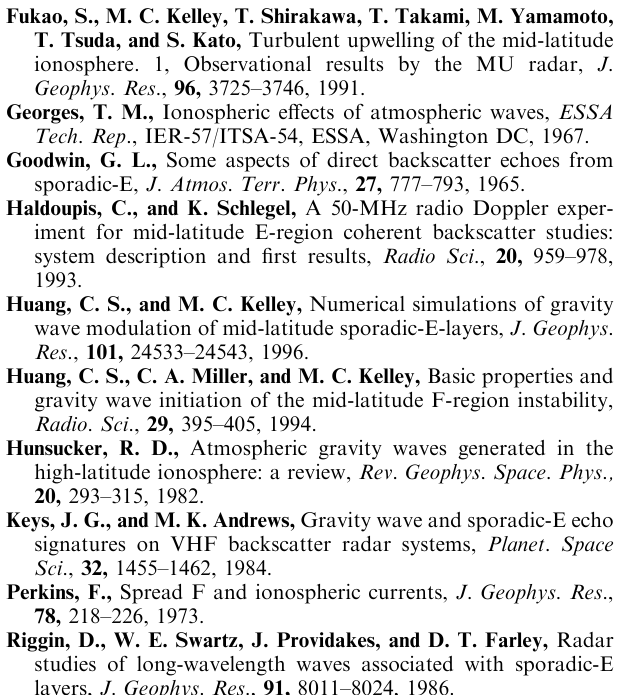
Fig. 11a–c. Data from vertical sounding measurements of F-region echoes: a virtual heights and b Doppler velocity. The third plot c shows the virtual height of the Es- layer at the smallest sounding frequency (2.5 MHz). The time-intervals A and B refer to those indicated in Figs. 9 and 10,